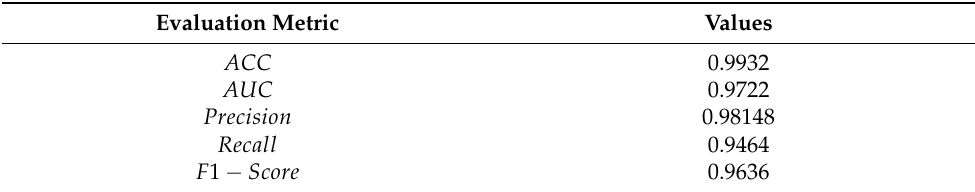
Table 7. The results of evaluation metric values obtained with application of the best symbolic expression ( y 1 ) in binary problem on the original dataset.